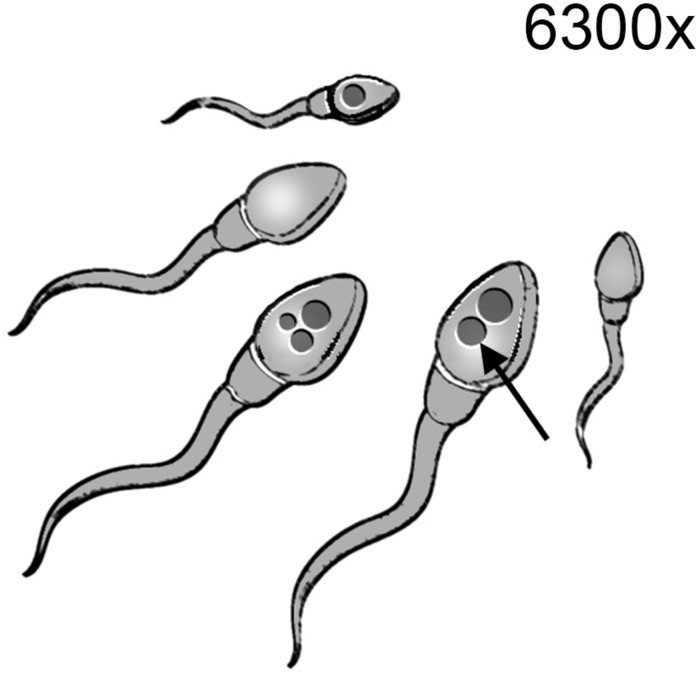
Intracytoplasmic morphologically selected sperm injection (IMSI). Spermatozoa are examined under a magnification system of 6300x in order to discriminate those spermatozoa lacking vacuoles (arrow) and showing normal morphology. These spermatozoa are collected with the micromanipulation system for their use in ICSI.